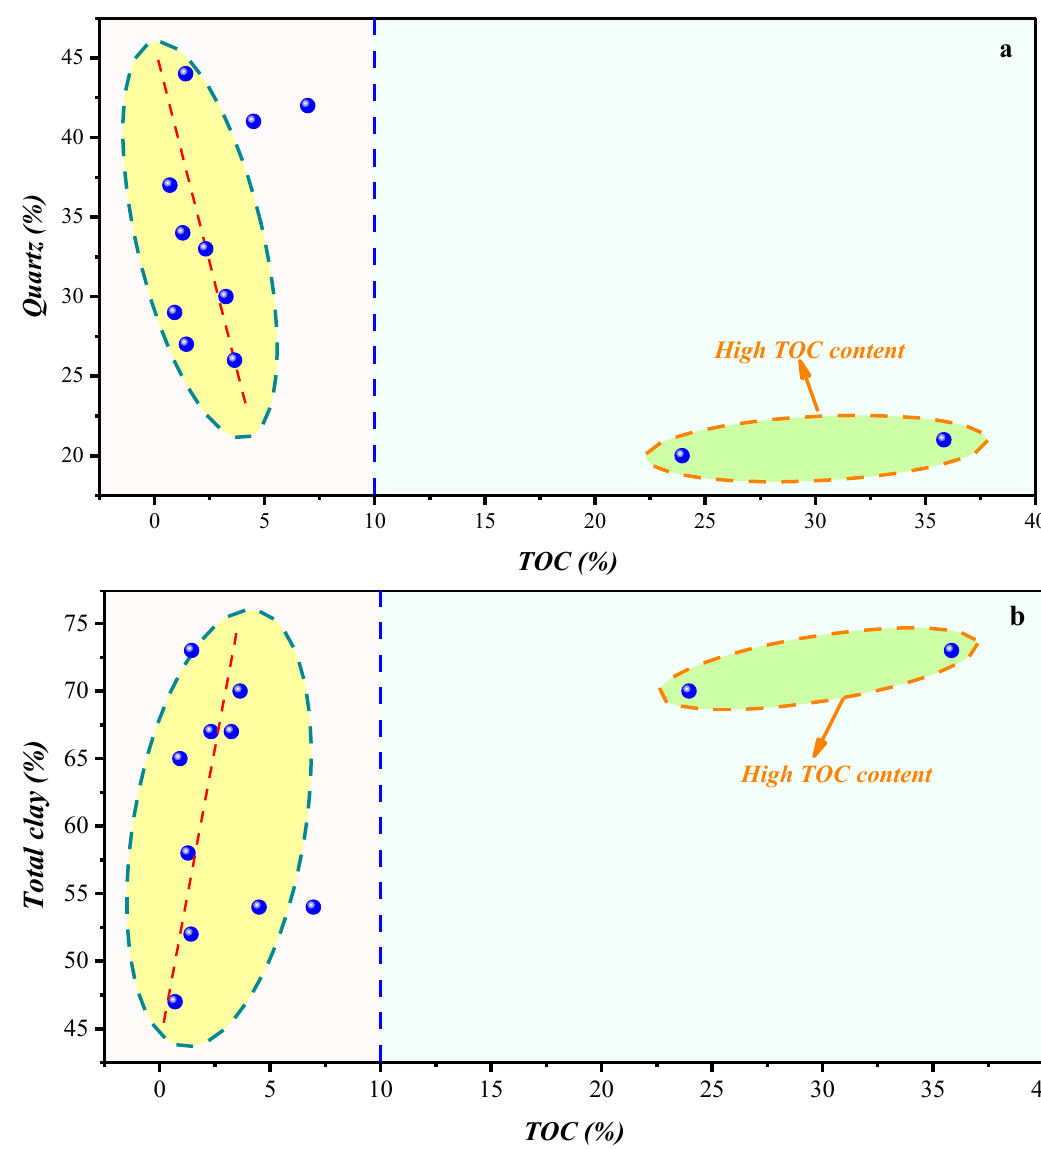
Figure 9. ( a ) Relationship between quartz content and TOC content; and ( b ) relationship between total clay content and TOC content.